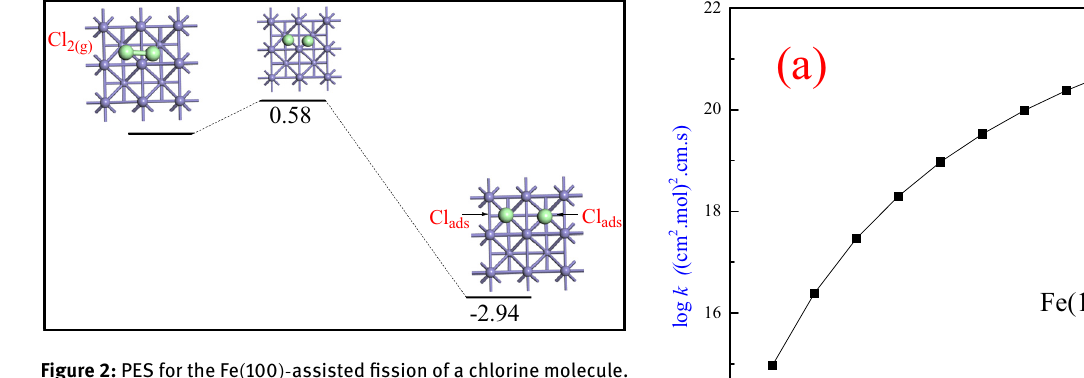
Figure 2: PES for the Fe ( 100 )- assisted fi ssion of a chlorine molecule. Values are in eV in reference to the adsorbed chlorine molecule.